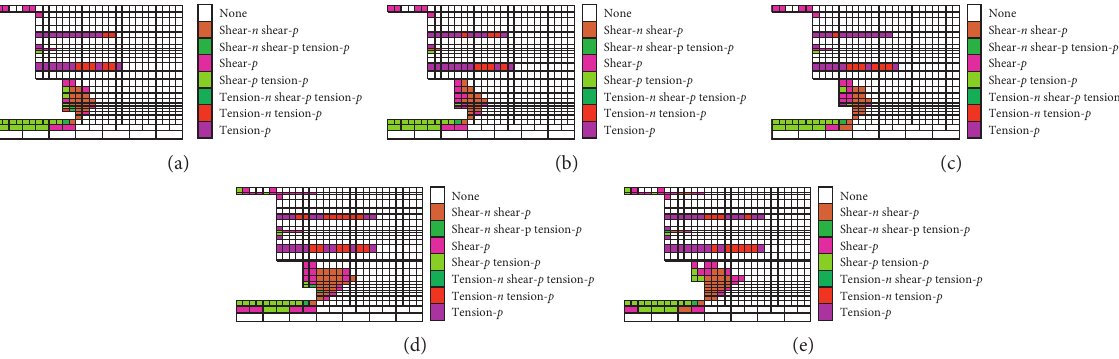
Figure 5: Distribution of damage zones with different mining height. (a) 3m mining height. (b) 4m mining height. (c) 5m mining height. (d) 6m mining height. (e) 7.5m mining height.